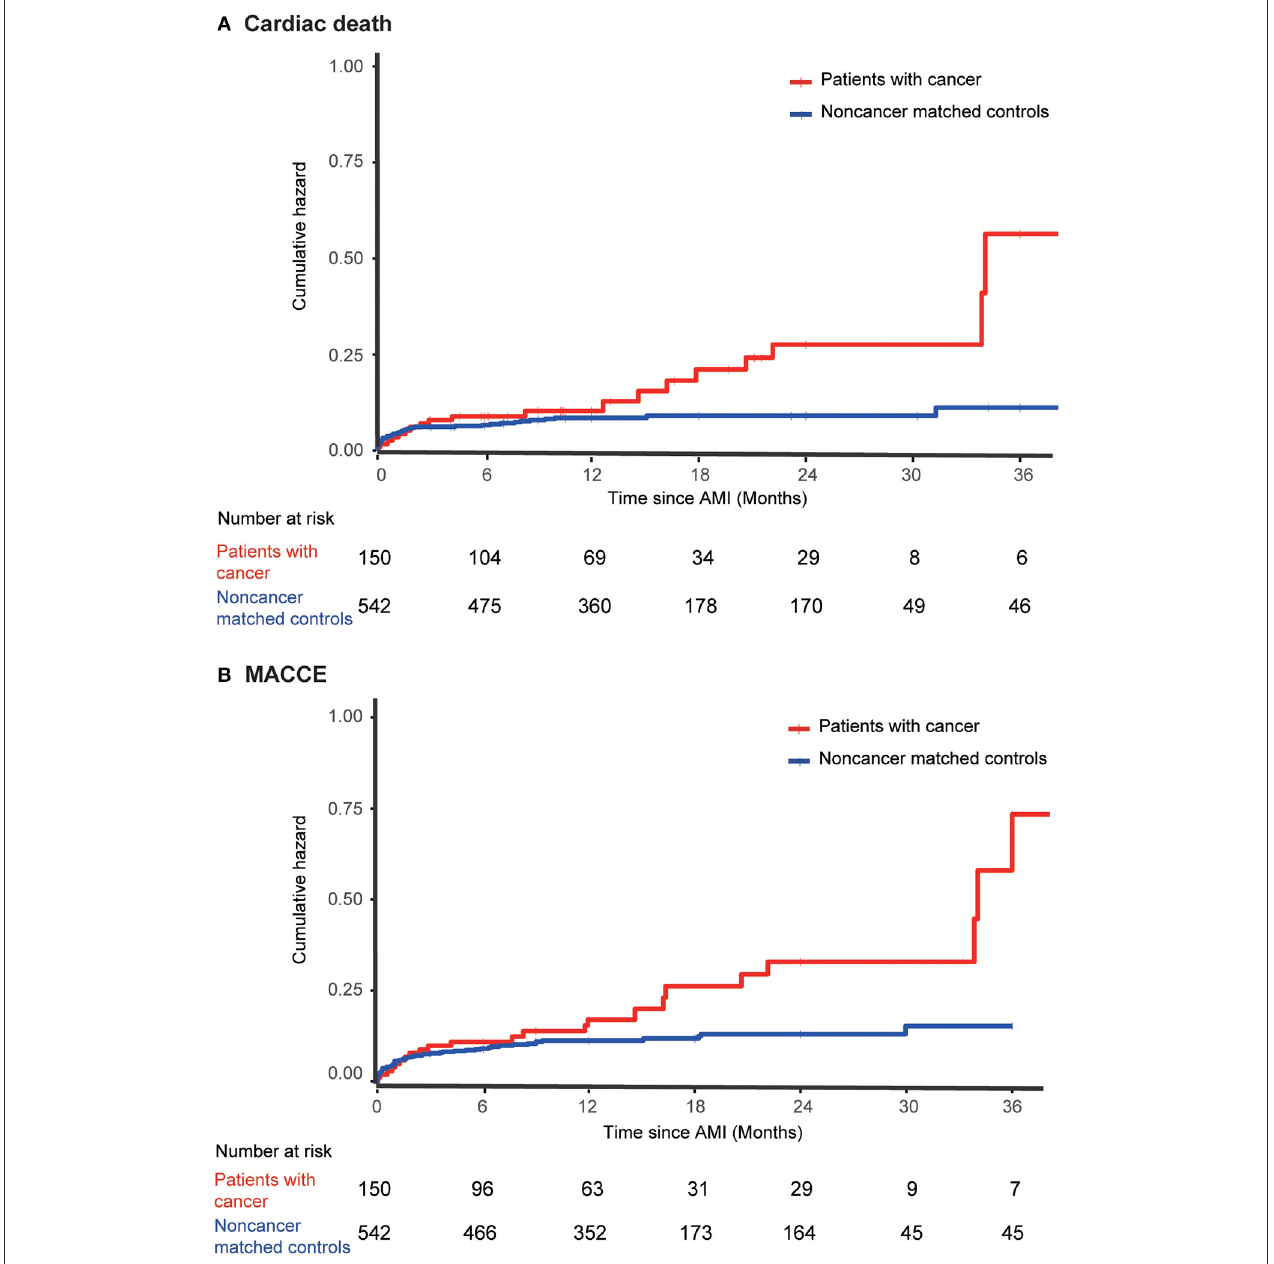
FIGURE 1 | Clinical outcomes among AMI patients with and without cancer. Displayed are the cumulative incidence curves for (A) cardiac mortality and (B) MACCE for cancer patients vs. controls. AMI, acute myocardial infarction; MACCE, major adverse cardiovascular and cerebrovascular events.